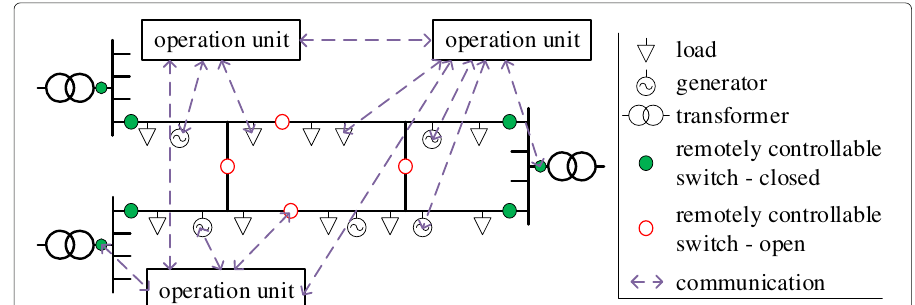
Fig. 3 Distributed operation architecture for the operation of a distribution grid. The three distributed operation units can exchange information with each other. Source: Adapted from Drayer